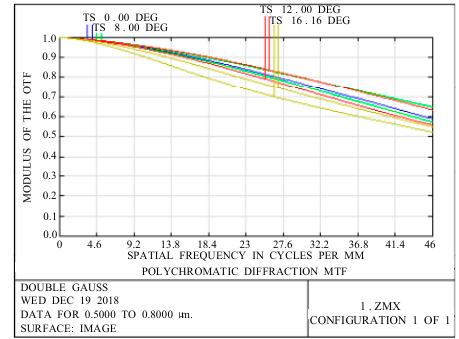
Figure 5. Field curve and distortion of the optical system.